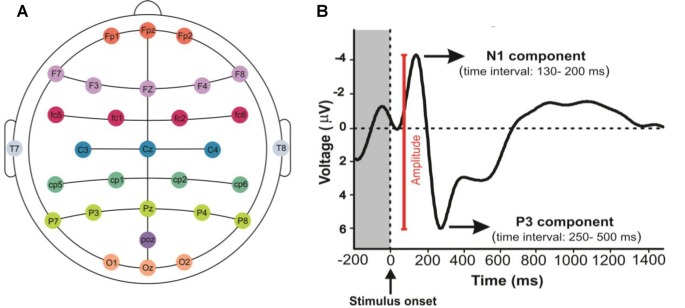
Mapping EEG Electrodes and event related potential (ERP) component signals: (A) it shows the position of electrodes on the scalp. (B) N1 and P3 components represent the N100 and the P300, respectively. The response amplitude was measured as the voltage from N1 to P3 components.